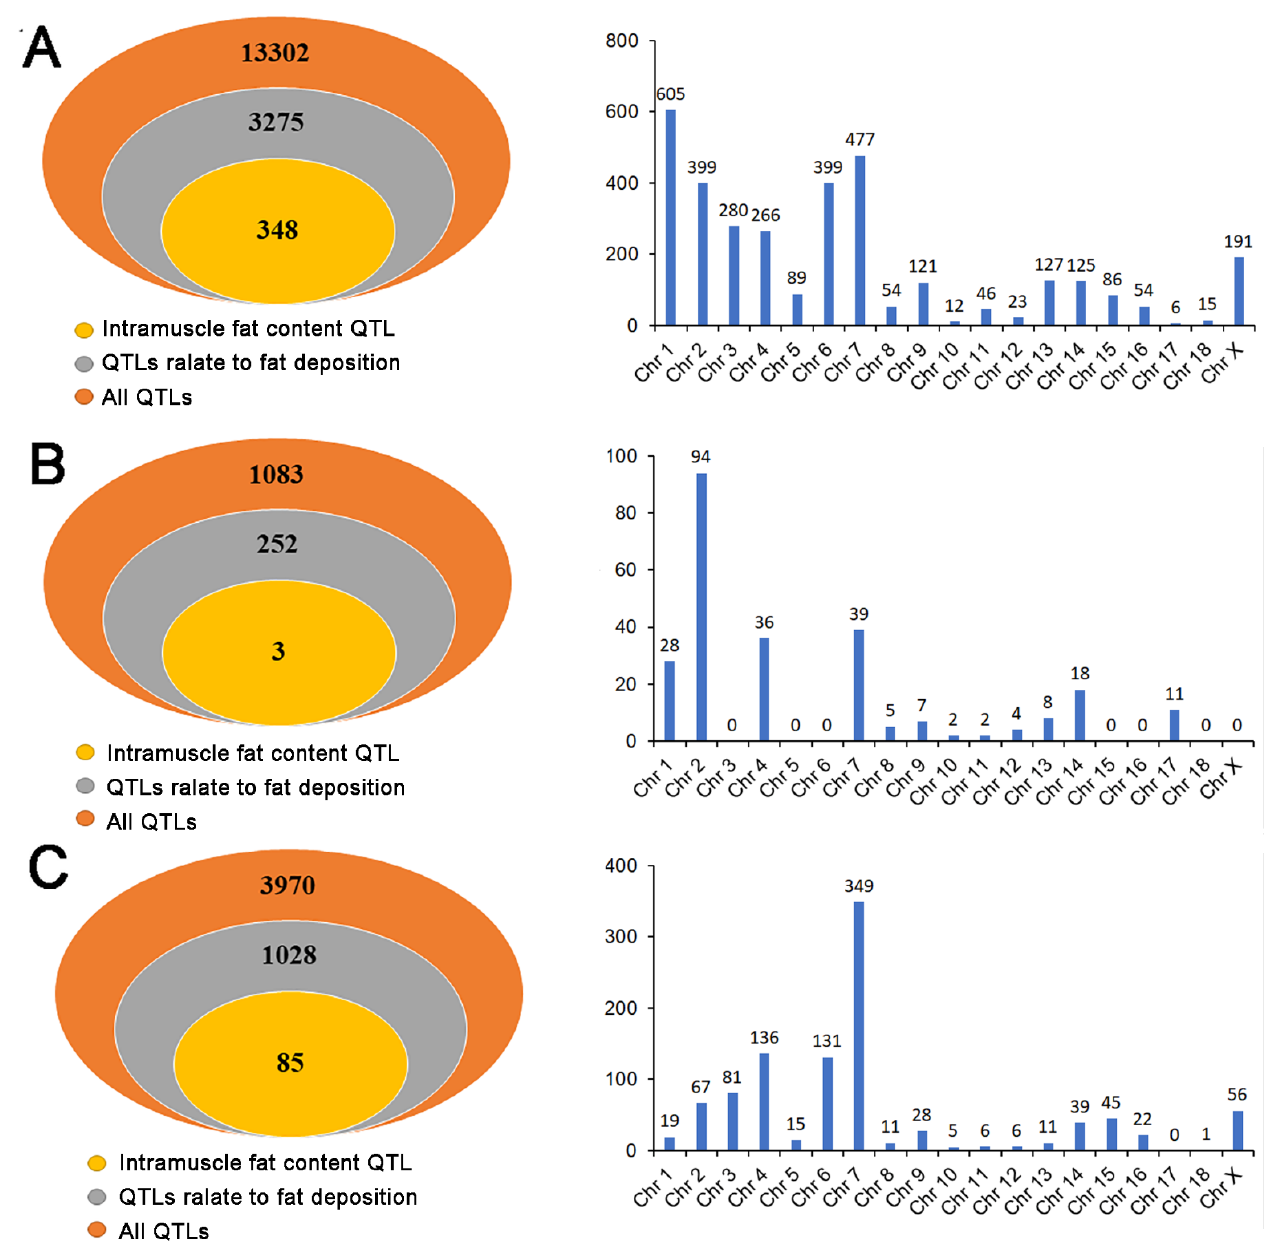
Figure 5. Quantitative trait locus analysis of DE RNAs. ( A ) The number distribution of QTLs related to fat deposition, the number of QTLs related to fat deposition, and the chromosome distribution of the QTLs related to fat deposition of the DE lncRNAs. ( B ) The number distribution of QTLs related to fat deposition, the number of QTLs related to fat deposition, and the chromosome distribution of the QTLs related to fat deposition of the DE miRNAs. ( C ) The number distribution of QTLs related to fat deposition, the number of QTLs related to fat deposition, and the chromosome distribution of the QTLs related to fat deposition of the DE